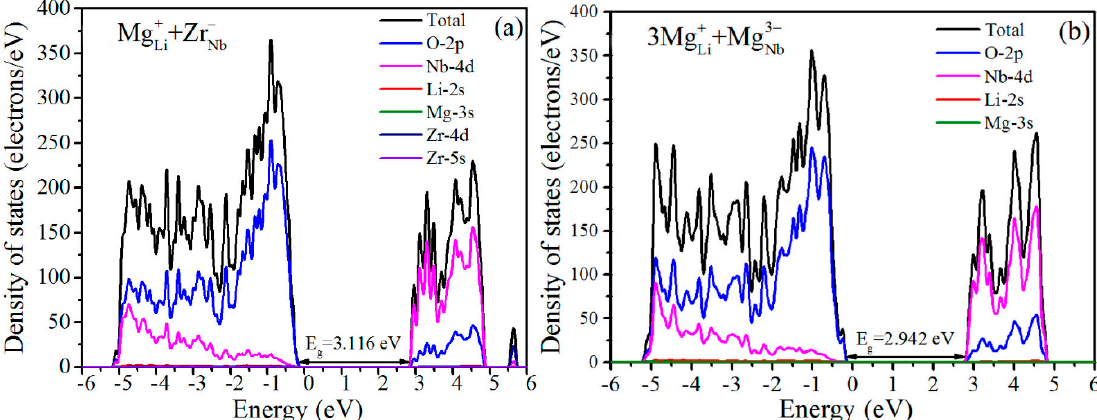
Figure 4. Density of states for ( a ) LN:Mg,Zr based on the Mg Li+ +Zr Nb– defect model. For comparison, that of ( b ) LN:Mg based on the 3Mg Li+ +Mg Nb3– cluster is also presented.